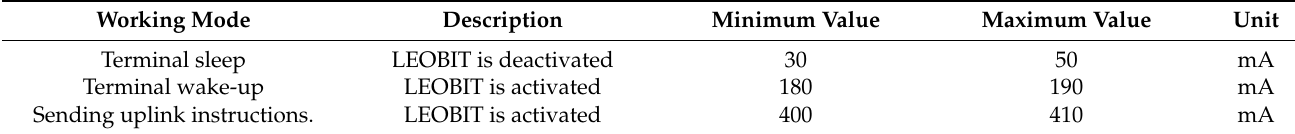
Table 1. The power consumption of LEOBIT satellite